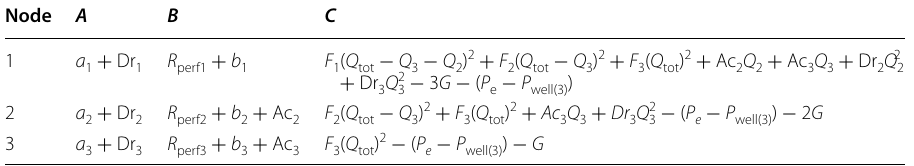
Table 1 Coefficients of the Eq. (10) for three interval case production side Node A